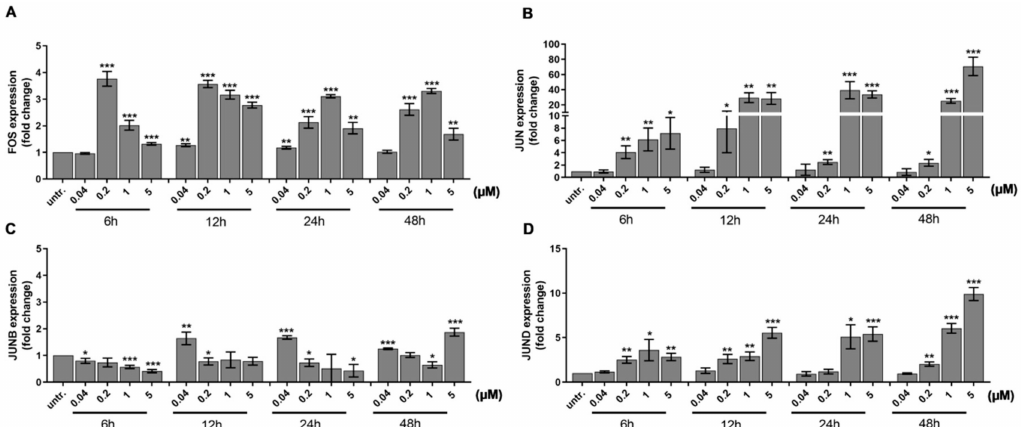
Figure 3. The expression of the members of the AP-1 TF (TF = transcription factor) complex, a driver of cellular di ff erentiation, FOS ( A ), JUN ( B ), JUNB ( C ), and JUND ( D ), was elevated in a concentration and time dependent manner detected by qRT-PCR. Cells were assayed as described in the Materials and Methods Section 4.9. Data are shown as arithmetic mean values ± standard deviation from triplicate experiments. Statistical significance was calculated in relation to untreated cells and set to * p < 0.05, ** p < 0.01, *** p <